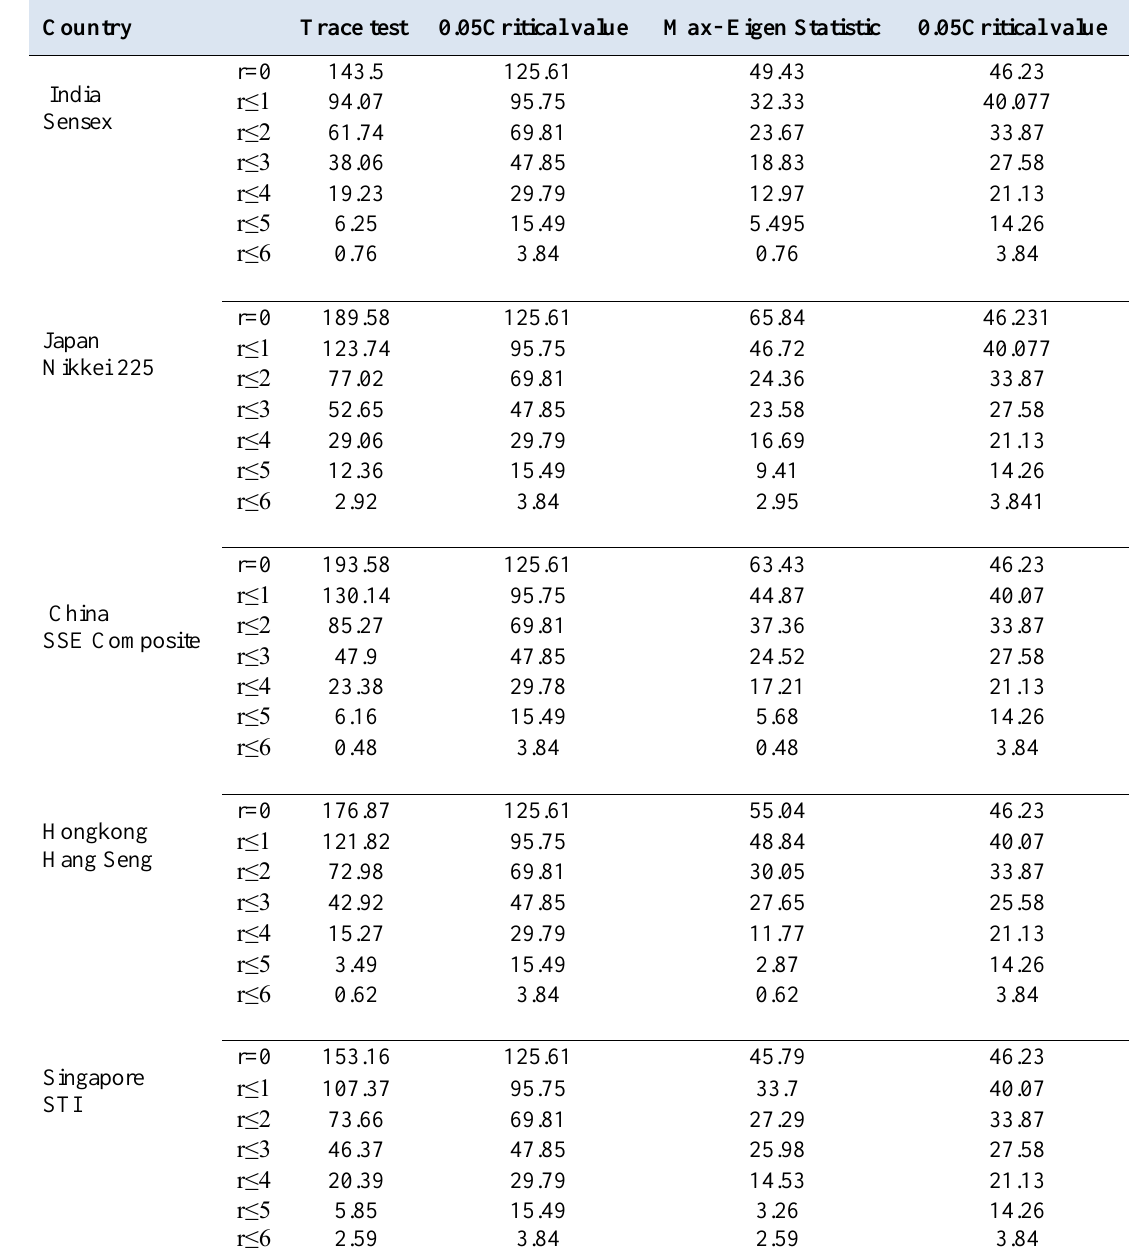
Table2 . Showing results of Johansen Cointegration Test for Asian Stock Marker returns and select macroeconomic